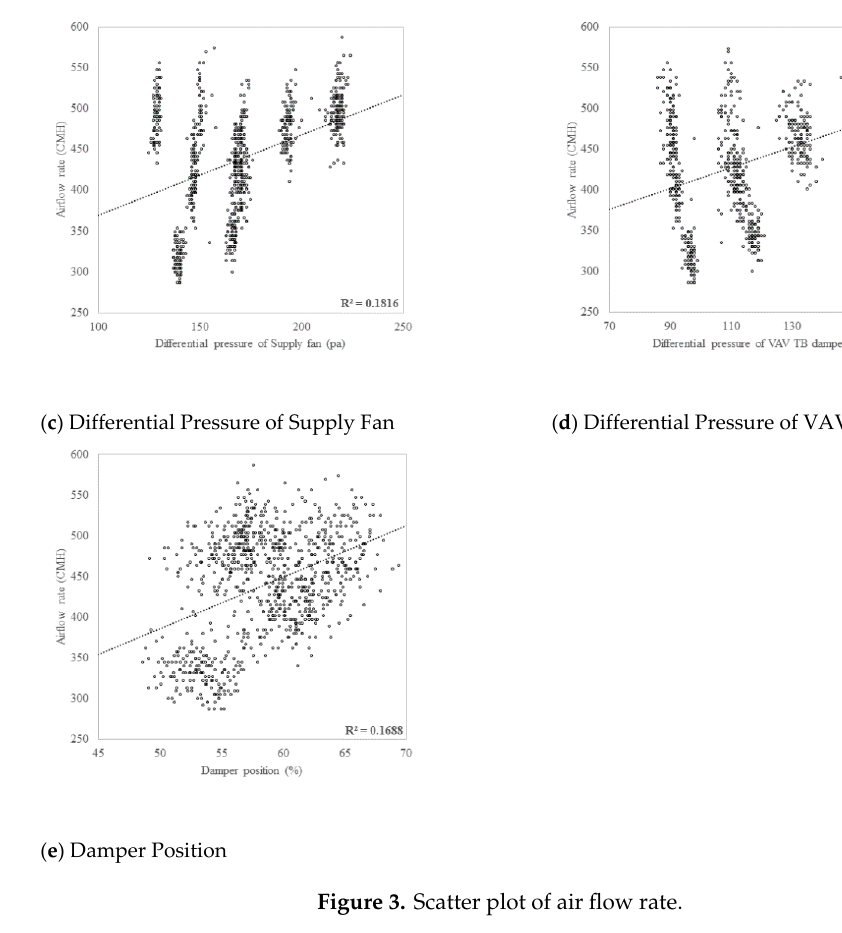
Table 5. Inputted and removed variables in the models.